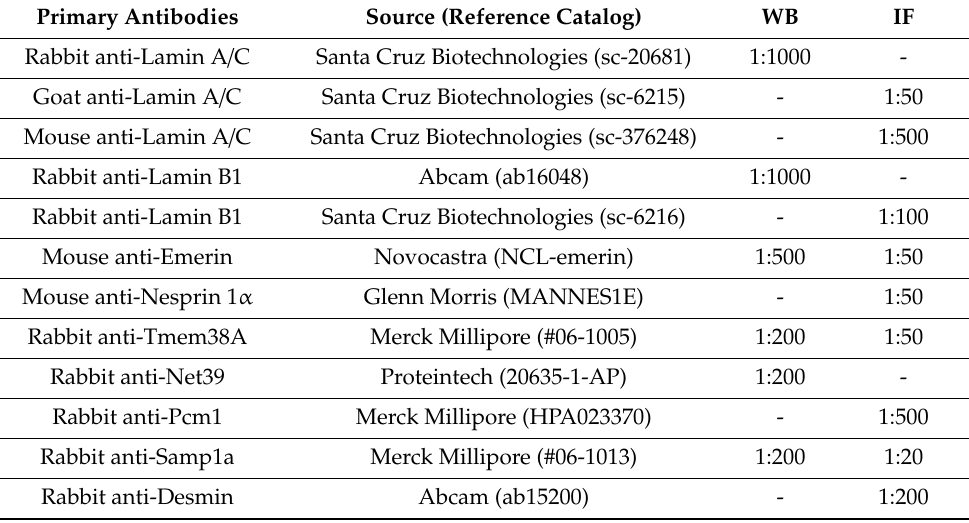
Table 1. List of antibodies and their dilutions used in Western blot (WB) and immunofluorescence (IF)